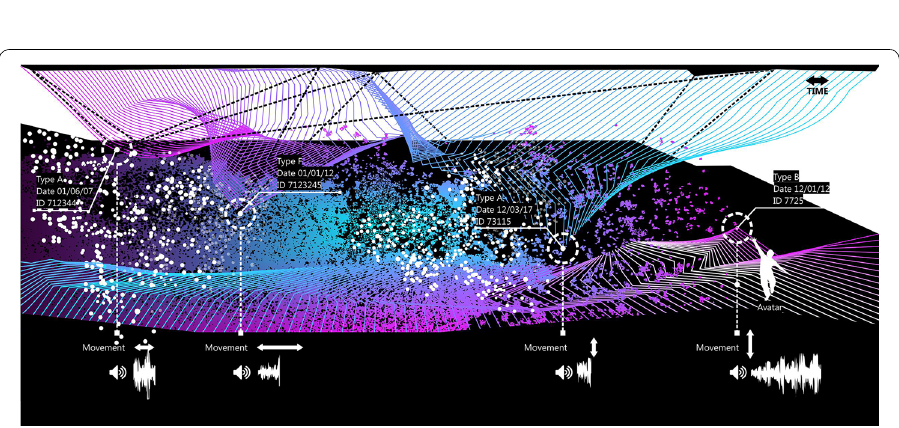
Fig. 5 Immersive Analytics Principle 2: natural affordance of mimetic reference overlaid with constructed